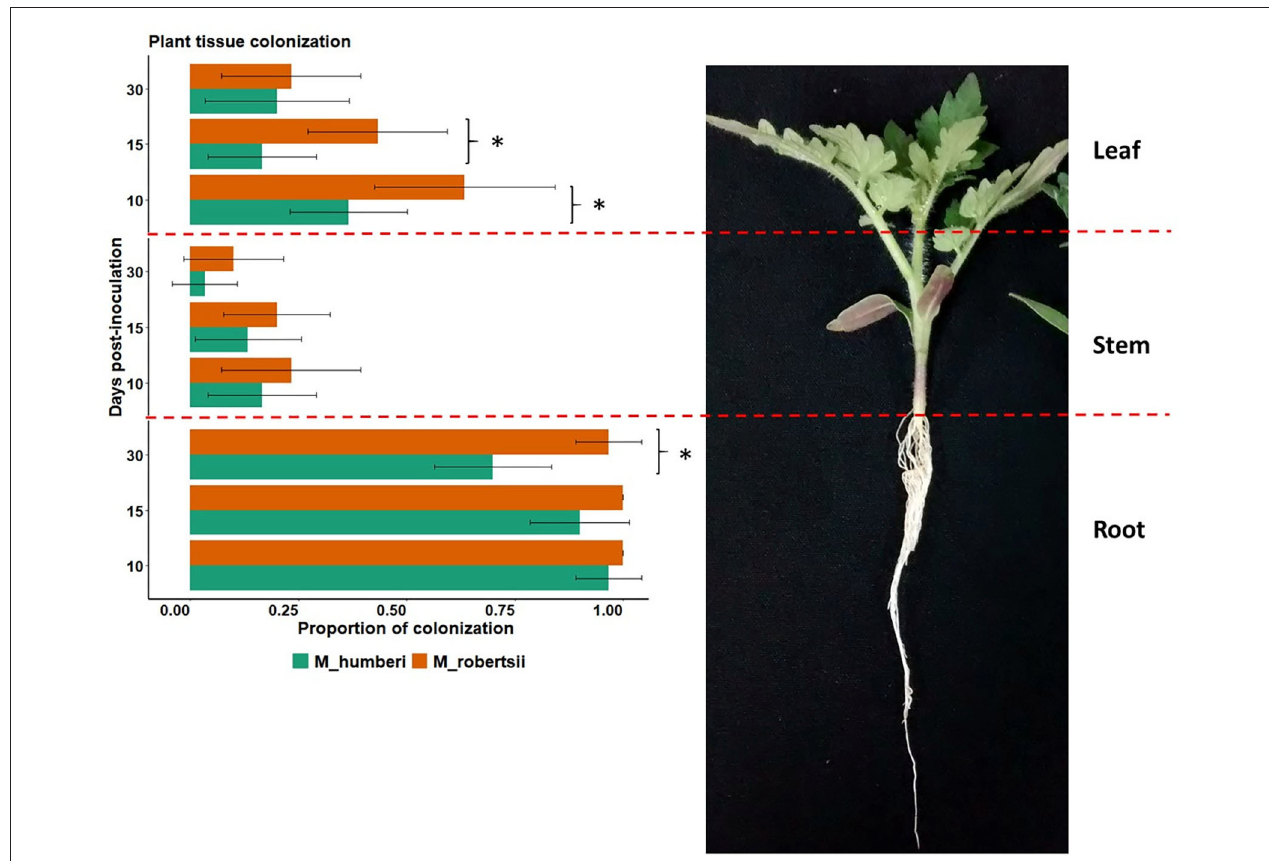
FIGURE 4 | Endophytic colonization of Micro-Tom tissues (leaf, stem, and root) by M. robertsii or M. humberi 10, 15, and 30 days after inoculation. Vertical bars represent the means ( ± 95% CI [confidence interval], n = 10), while asterisk (*) designates significant difference between fungal species at P < 0.05 (Tukey HSD test).